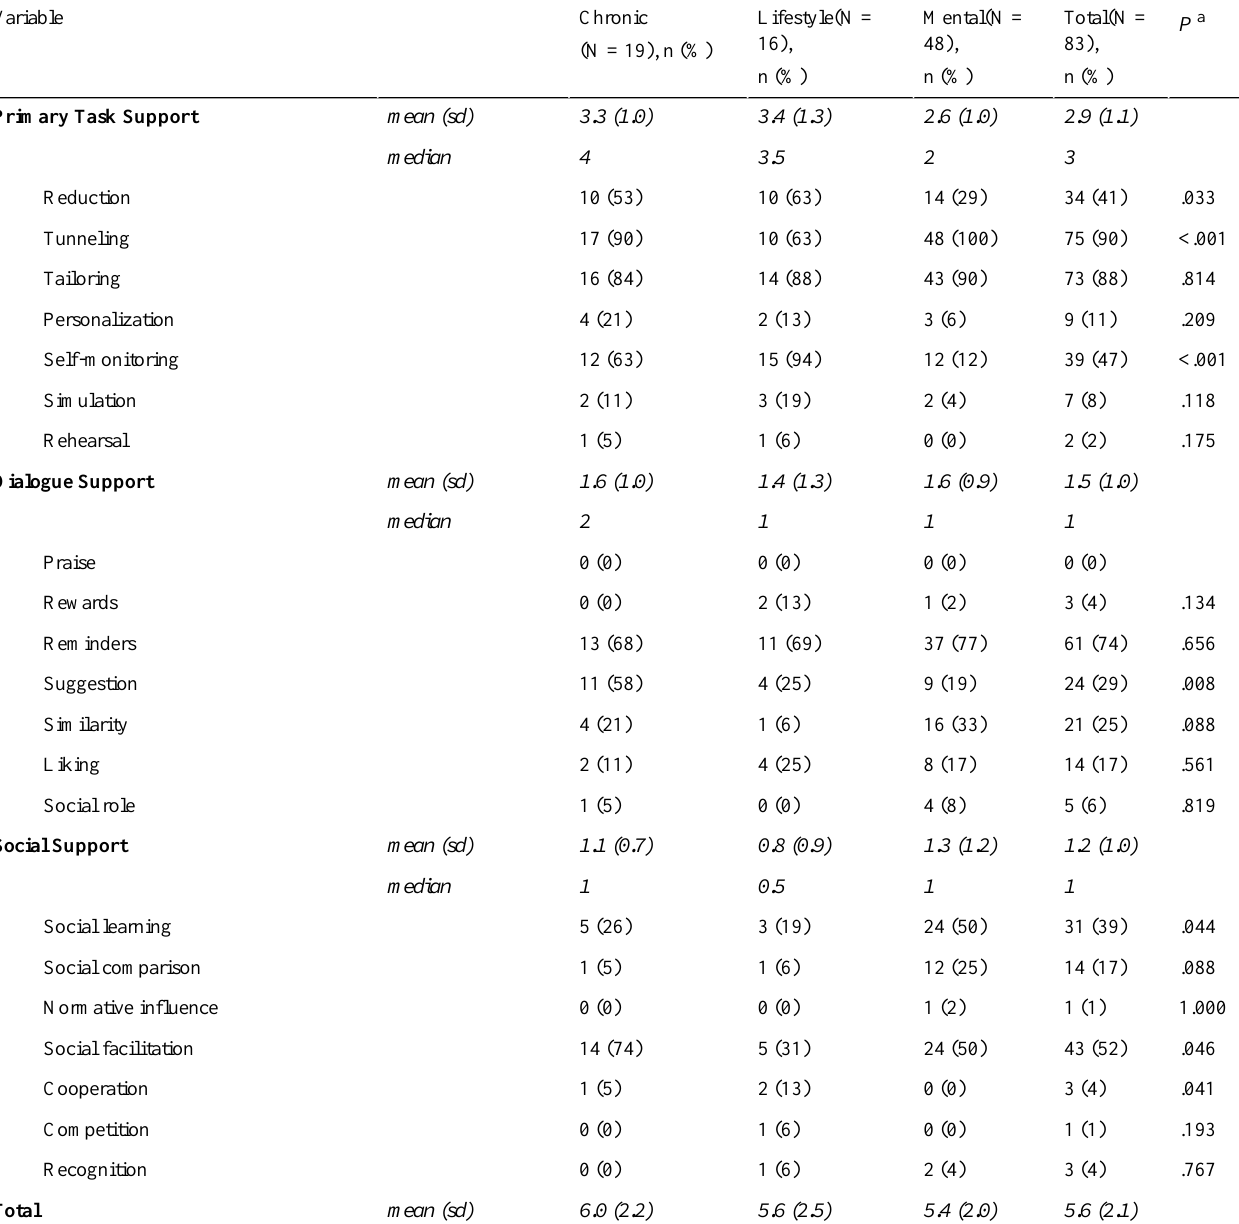
Table 3. Persuasive technology in web-based interventions included in this study per health care area.